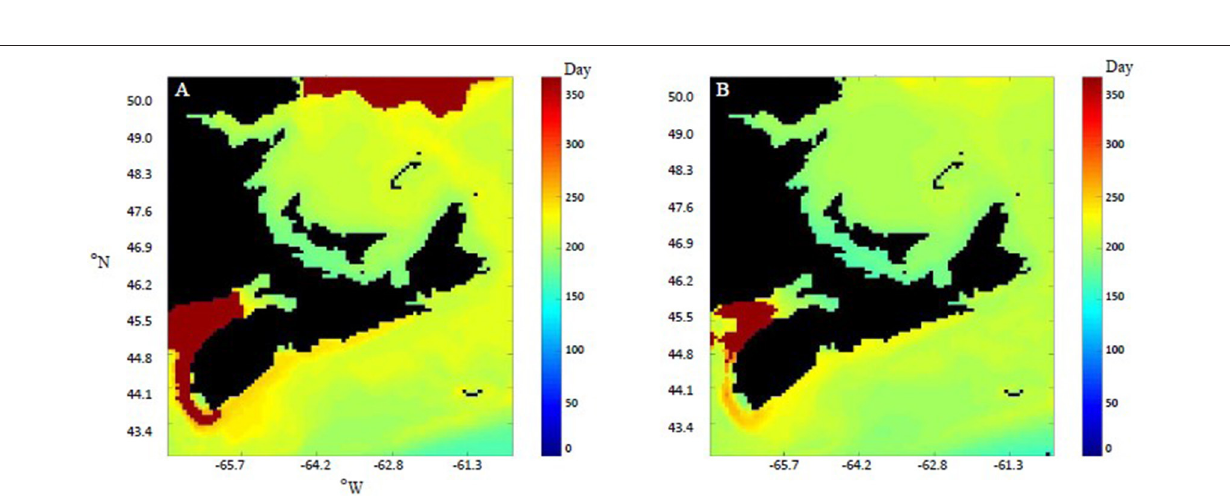
FIGURE 5 | Difference (%) in length (SL) (A,B) and gonadosomatic index (GSI) (C,D) of C. virginica and M. edulis between the past (1986–1990) and the future (2046–2050), calculated after 1 year of growth.